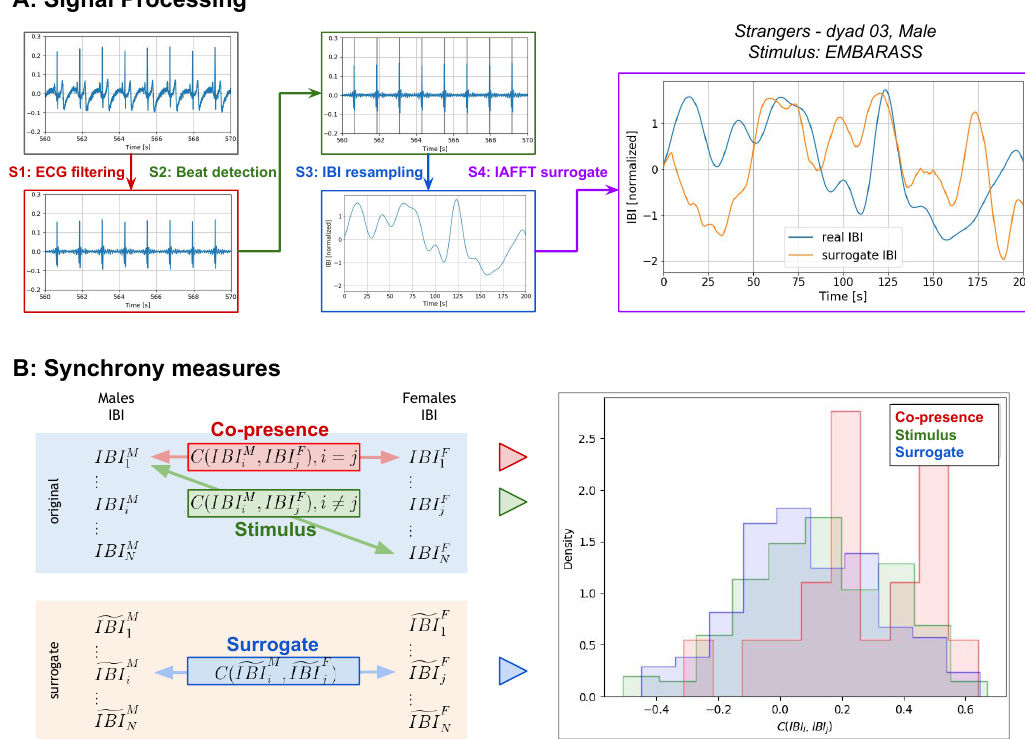
Figure 1. Data analysis: ( A ) Pipeline for the processing of the electrocardiogram (ECG) signal with the four main steps and the final result with the real and surrogate inter-beat interval (IBI) series signal for one subject and stimulus. ( B ) Three types of physiological synchrony and computation schemes, with the output distribution of the